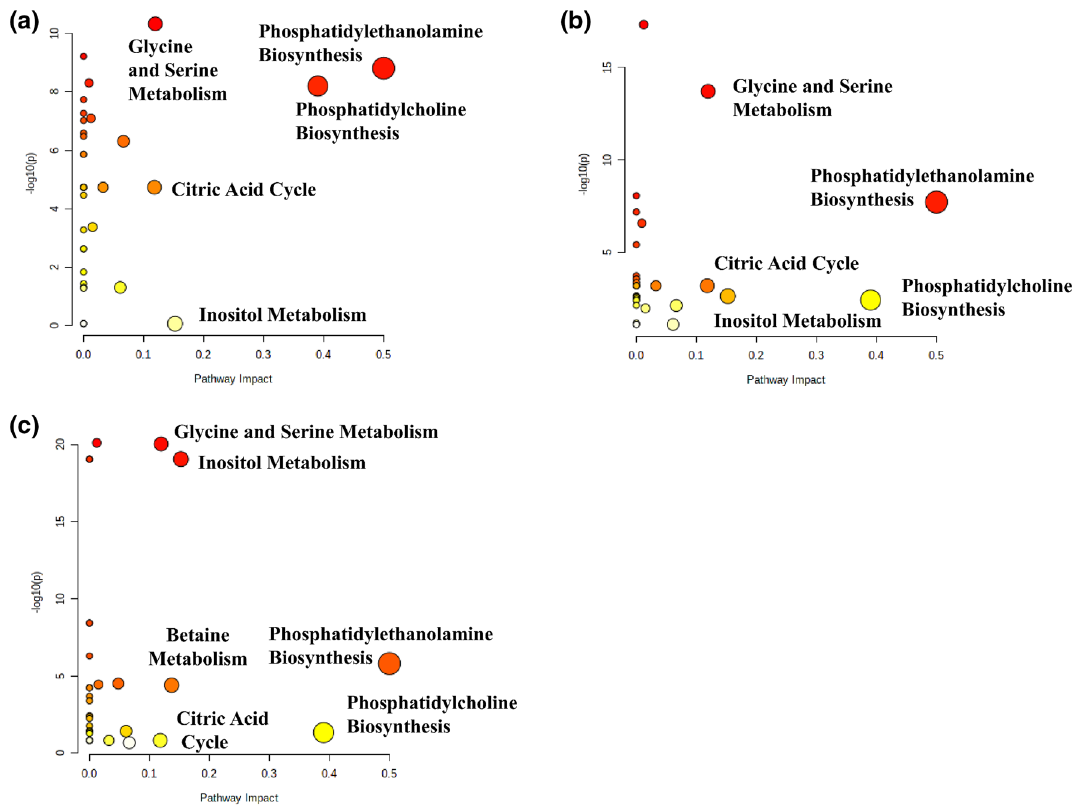
Figure 8. Metabolome views obtained from the pathways analysis presenting the pathways altered in ( a ) G1 vs. healthy tissue, ( b ) G2 vs. healthy tissue, ( c ) G3 vs. healthy tissue. The image was created using Metaboanalyst 4.0 software (https:// www. metab oanal yst.